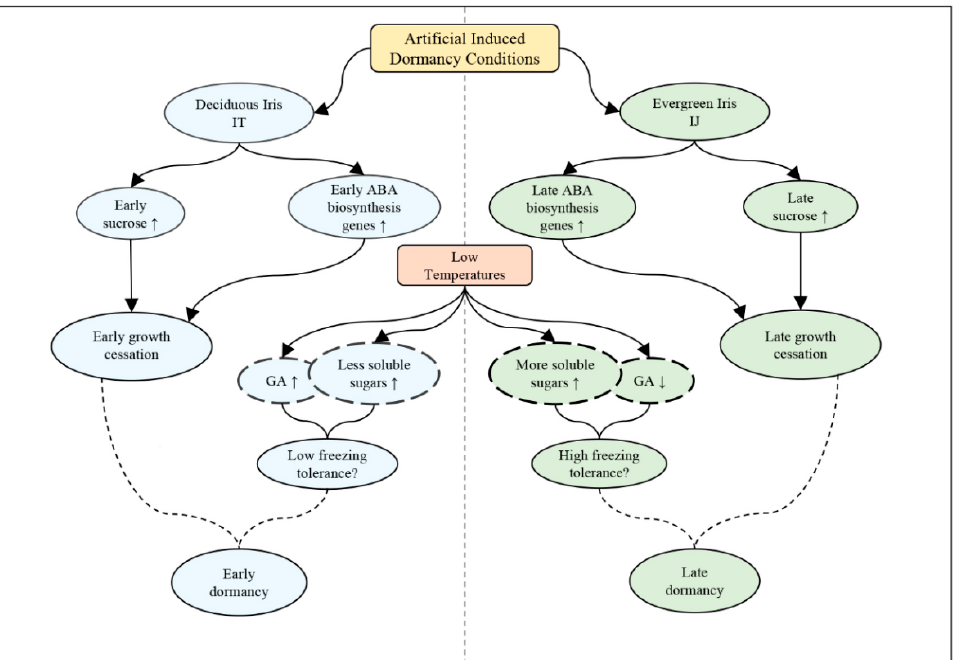
Figure 7. Proposed model of the reason for later dormancy in evergreen iris compared with deciduous iris under artificial induced dormancy conditions. Blue represents IT, and the green represents IJ. Solid wireframes represent physiological and molecular responses in apical shoot tissues, dotted wireframes represent physiological and molecular responses in leaf tissues.